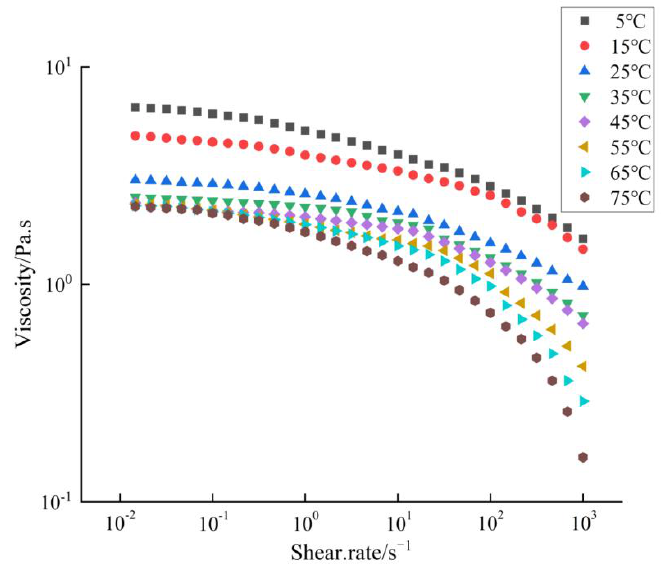
Figure 2. Variation of apparent viscosity of SAFP with temperature treatment.